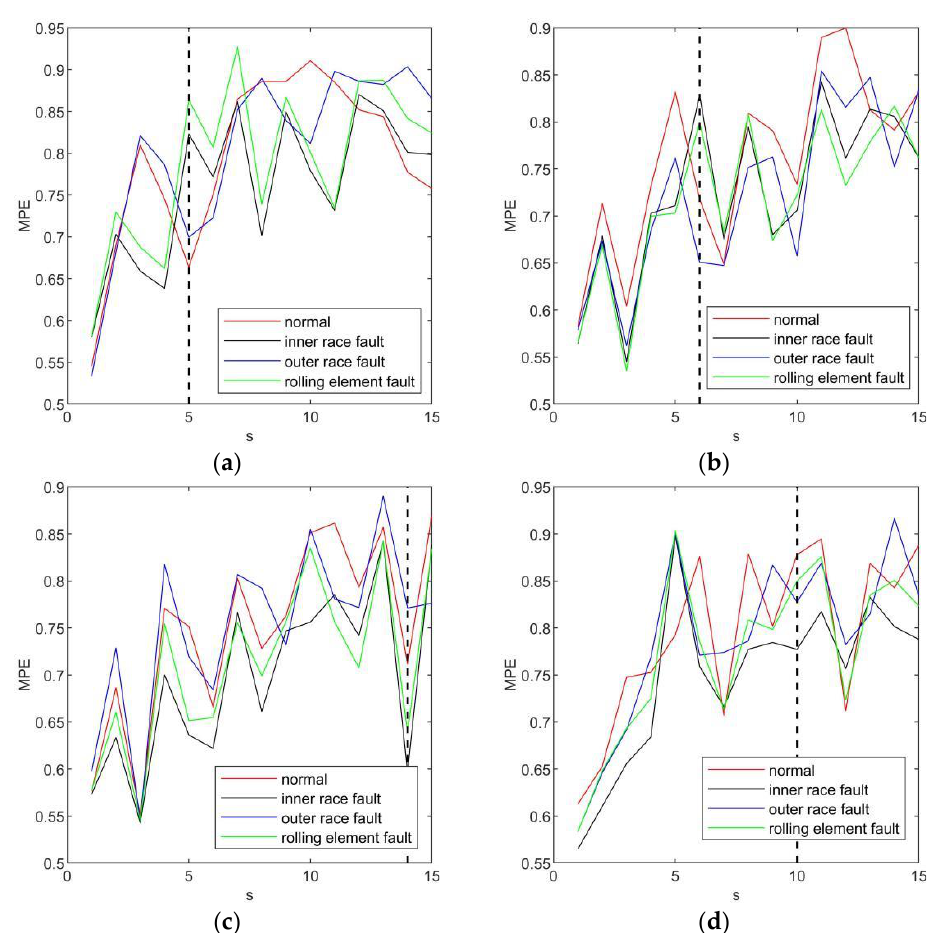
Figure 8. MPE of four intrinsic mode functions: ( a ) imf 1, ( b ) imf 2, ( c ) imf 3, ( d ) imf 4.